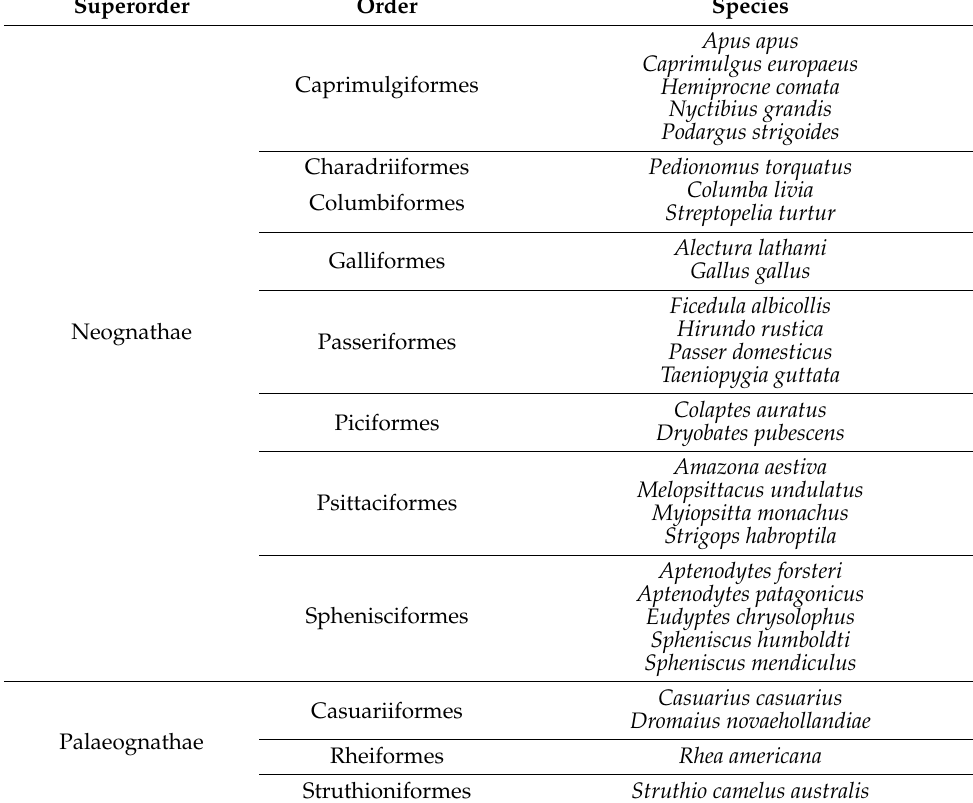
Table 1. Species analyzed in this